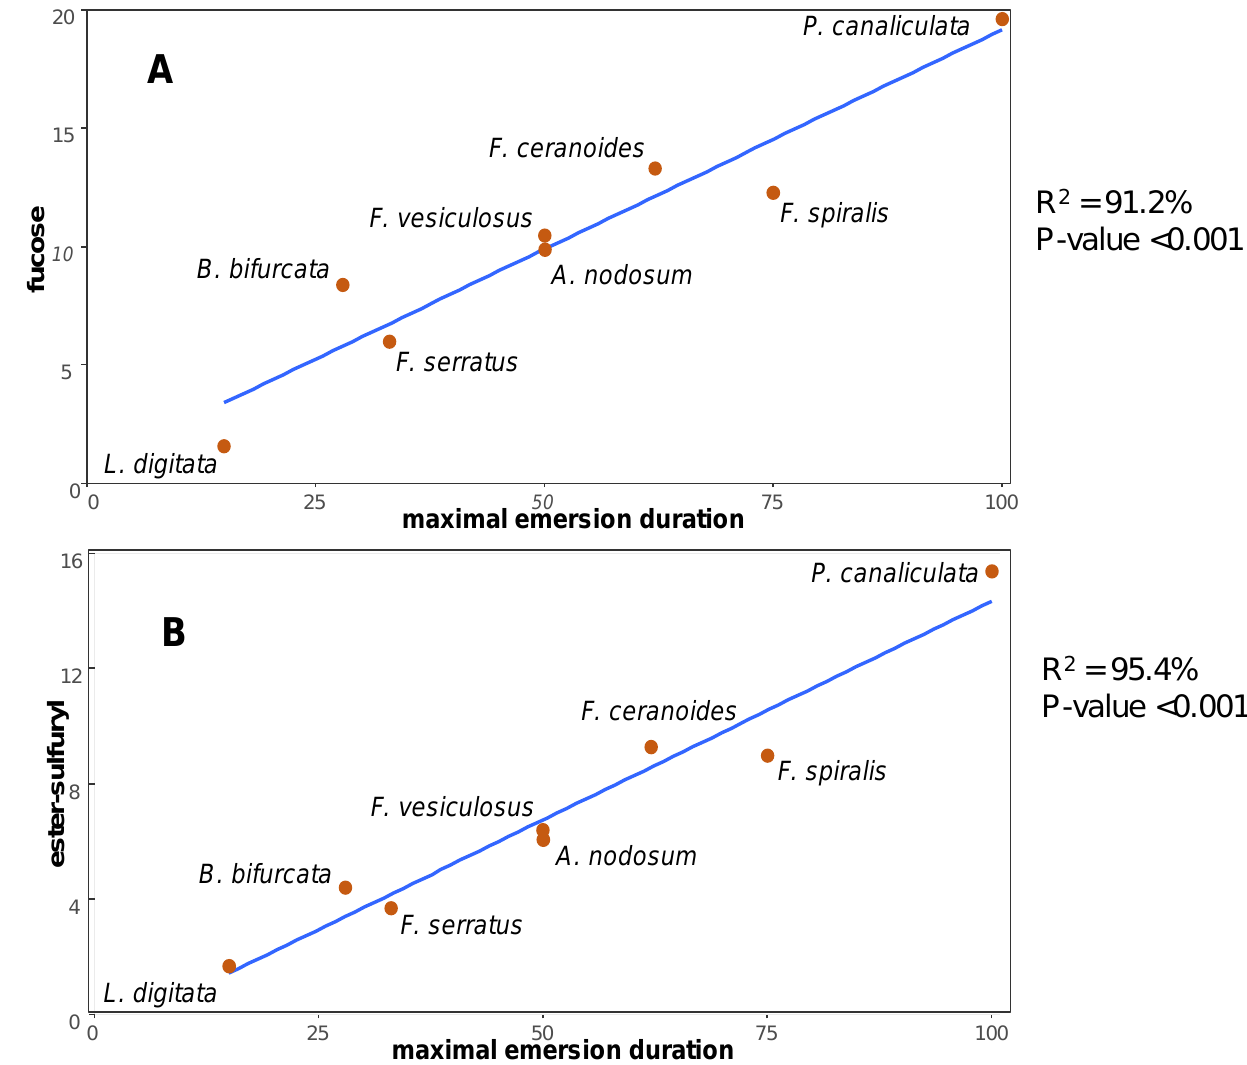
Figure 5. Correlation between the sulfated fucan content of isolated cell walls of brown algae and their position in the intertidal zone. ( A ). Fucose content (% w / w ) vs. duration of emersion (% of time). ( B ) Sulfate substituent content (% w / w ) vs. duration of emersion. The maximal duration of emersion in a daily tidal cycle was calculated for Roscoff (Brittany, France), based on species belt zonation in the intertidal (taken as the medium height relative to the lowest astronomical tide), using the spring tide mid-water mark for Pelvetia canaliculata, Fucus ceranoides, F. spiralis, F. vesiculosus , and Ascophyllum nodosum and the neap tide mid-water mark for F. serratus , Bifurcaria bifurcate , and Laminaria digitata . See Supplementary Table S2 for the corresponding data